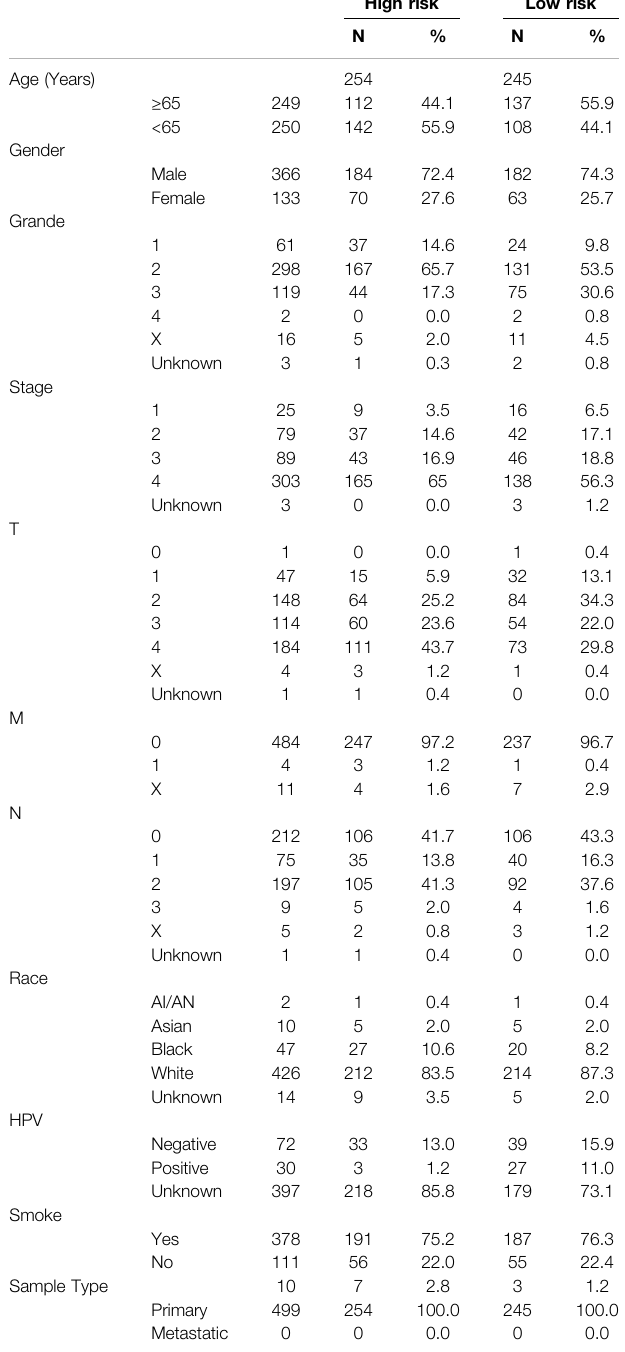
TABLE 4 | Demographic data from TCGA